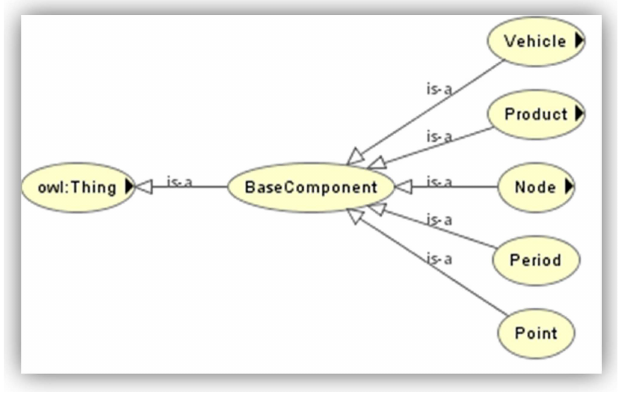
Figure 4. The BaseComponent